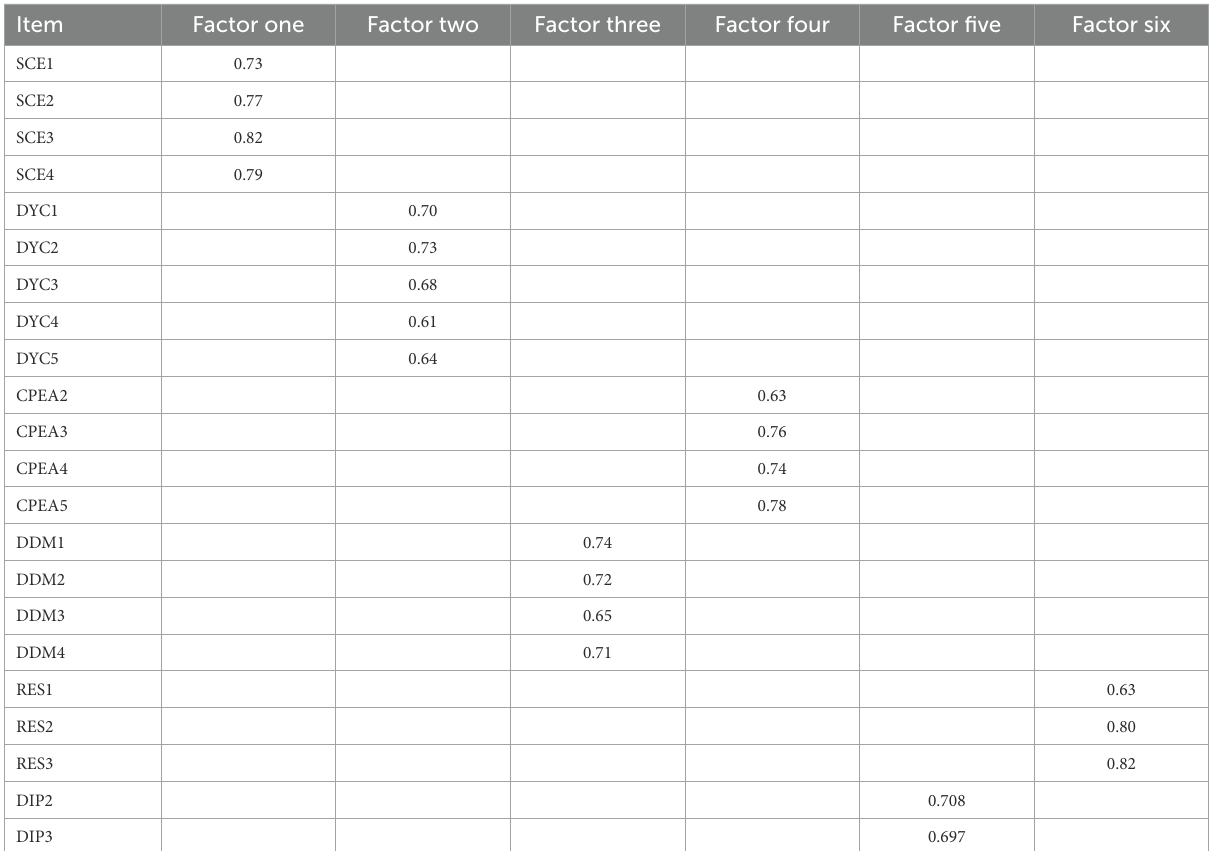
TABLE 3 Factor loadings of the EFA SX scale.